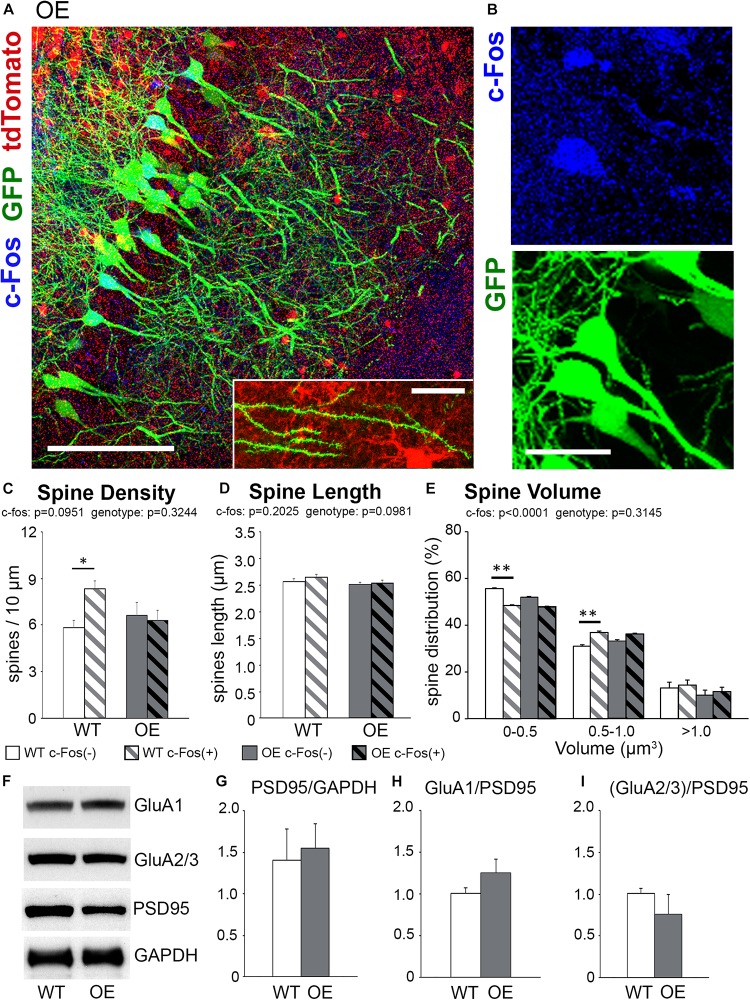
The increase in spine density on c-Fos(+) neurons compared to c-Fos(–) neurons is impaired in OE mice. (A) Confocal images of the CA1 neurons expressing GFP (green) and astrocytes expressing tdTomato (red). Some neurons show c-Fos immunoreactivity (blue), scale bar is 100 μm. High magnification image shows example of dendritic spines located in a close proximity to tdTomato-expressing astrocytes, scale bar is 20 μm (insert). (B) High magnification images of c-Fos(+) (blue) and GFP-expressing (green) CA1 pyramidal neurons. (C–E) Graphs show the average number of dendritic spines per 10 μm dendrite (C), spine length (D), and spine volume (E) in c-Fos(+) and c-Fos(–) neurons from WT and OE mice. (C) There was an increased dendritic spine density in WT c-Fos(+) neurons compared with WT c-Fos(–) neurons [two-way ANOVA, c-Fos F(1,41) = 2.920, p = 0.0951; genotype F(1,41) = 0.995, p = 0.3244; interaction F(1,41) = 4.787, p = 0.0344; Bonferroni’s post hoc
∗p < 0.05 c-Fos(+) WT vs. c-Fos(–) WT]. (D) Spine length was no different between c-Fos(–) and c-Fos(+) neurons in both WT and OE mice. (E) A significant decrease in the percentage of smaller spines (<0.5 μm3) and an increase in the percentage of larger spines (0.5–1.0 μm3) were seen in c-Fos(+) neurons compared c-Fos(–) neurons with no effect of genotype [two-way ANOVA, c-fos F(2,141) = 837.4, p < 0.0001; genotype F(3,141) = 1.194, p = 0.3145 Bonferroni’s post hoc
∗∗p < 0.01 c-Fos(–) WT vs. c-Fos(+) WT]. (F) Western blots show levels of AMPAR subunits (GluA1 and GluA2/3), PSD95, and GAPDH in synaptosomes isolated from the hippocampus of WT and OE mice 1 h after context A recall. (G–I) Graphs show ratios of synaptic PSD95 to GAPDH (G), GluA1 to PSD95 (H), or GluA2/3 to PSD95 (I). Graphs show mean values and error bars represent SEM; ∗p < 0.05, ∗∗p < 0.01.